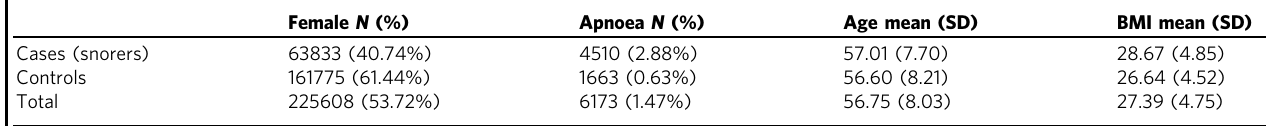
Table 1 Sample composition and descriptive statistics of UK Biobank discovery